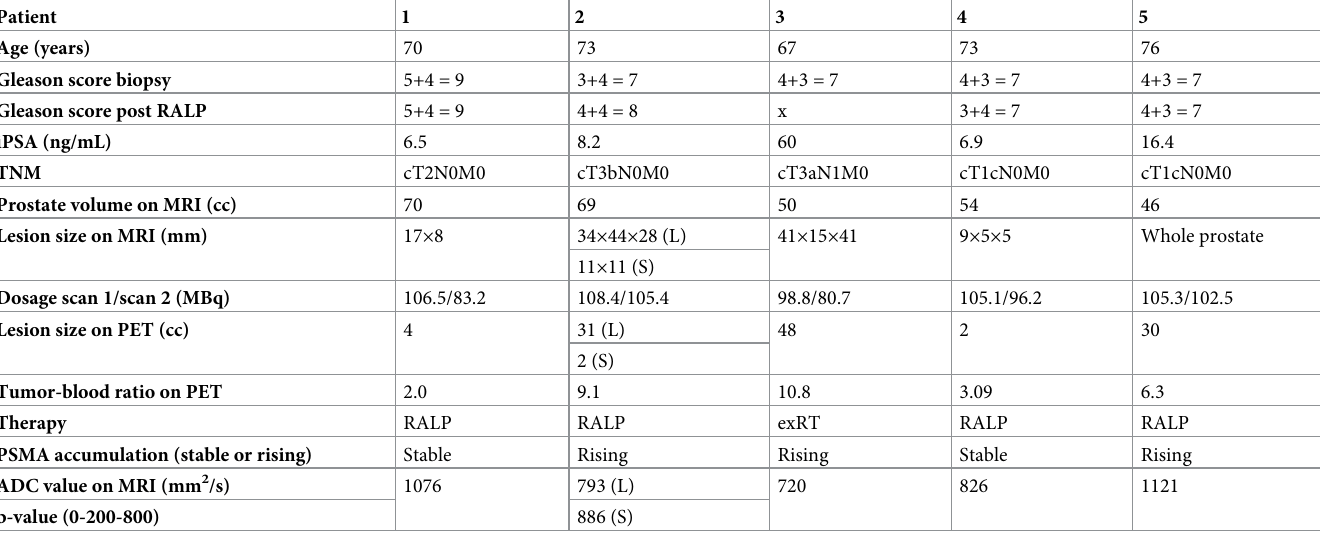
Table 1. Demographics of the 5 patients included in this study. Data is shown as absolute number (percentage) or as mean